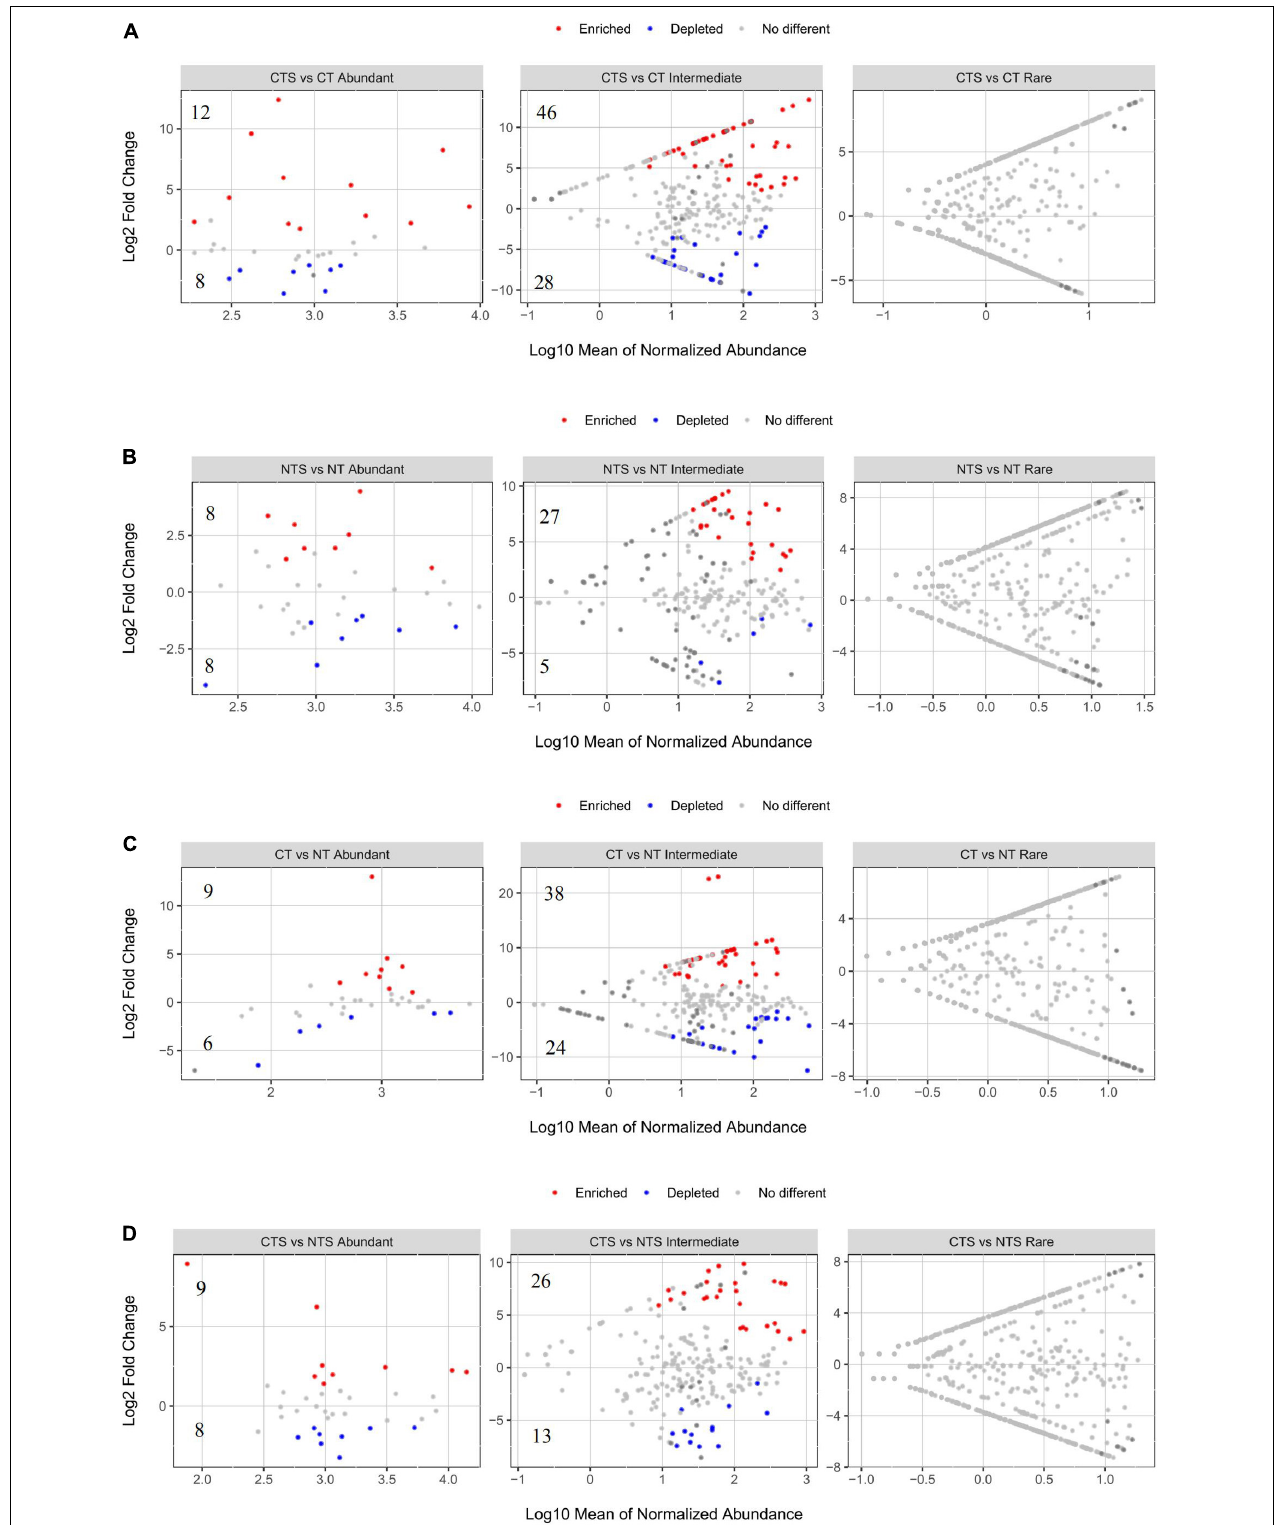
FIGURE 2 | Volcano plots illustrating OTUs significantly enriched (red) and depleted (blue) by straw mulching (A,B) and tillage (C,D) managements for fungal sub-communities. Each point indicates an individual OTU.